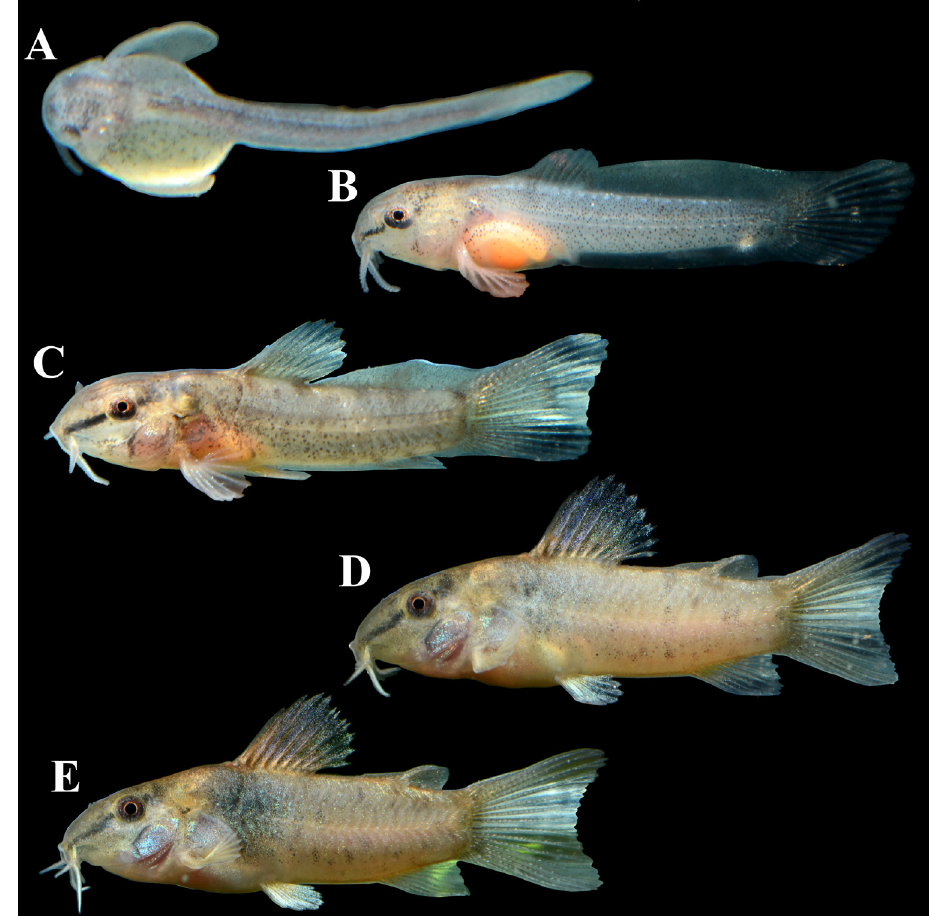
FIGURE 11 | Ontogenetic series of Corydoras maclurei (bred under aquarium conditions) showing general changes in external morphology and color pattern in specimens with 8.0 mm TL ( A ), 12.0 mm TL ( B ), 16.0 mm TL ( C ), 21.0 mm TL ( D ), and 28.0 mm TL ( E